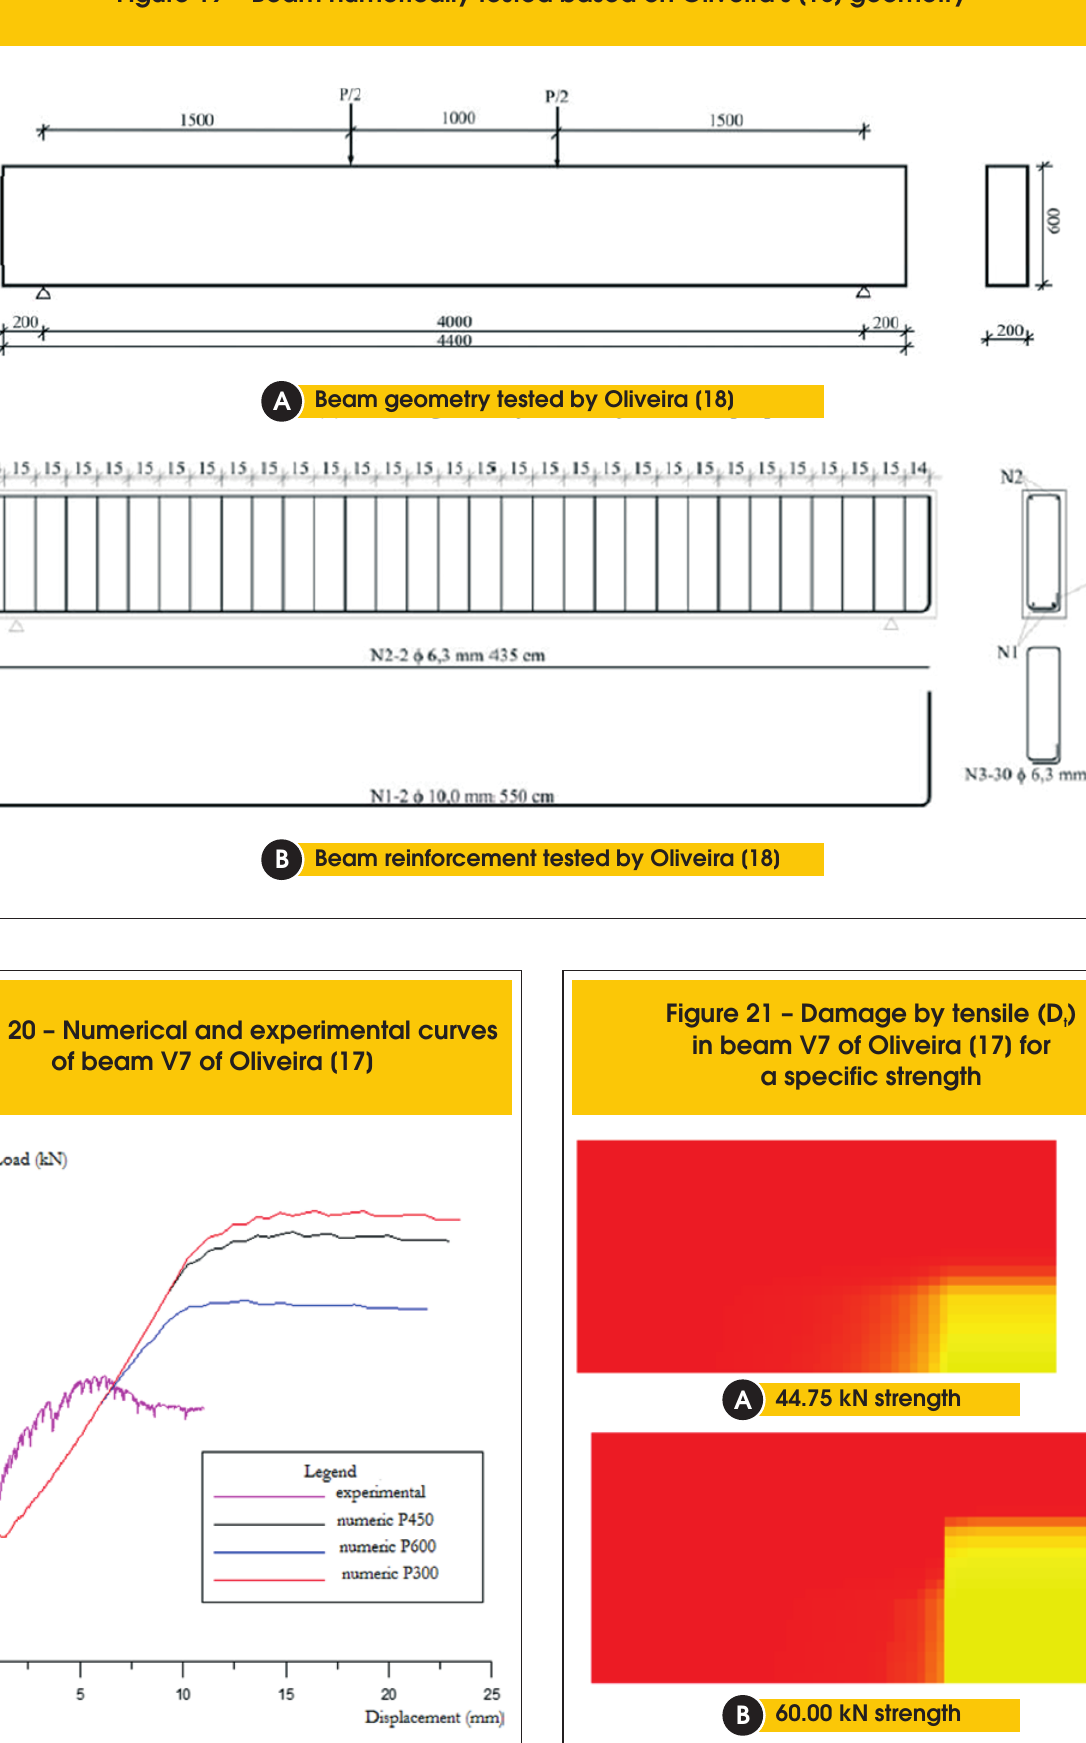
Figure 19 – Beam numerically tested based on Oliveira's [18] geometry